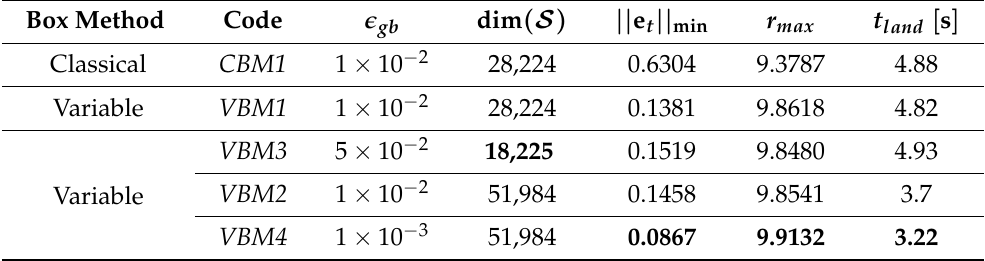
Table 1. Comparative study results between CBM and VBM under different conditions of the goal-box resolution and state-space dimension. The best metrics ( (cid:101) gb , || e t || min , r max , t land [s]) were obtained with VBM4 at the expense of a higher computational load (dim ( S ) = 51,984). Box Method Code (cid:101) gb dim ( S ) || e t || min r max t land [ s ] Classical